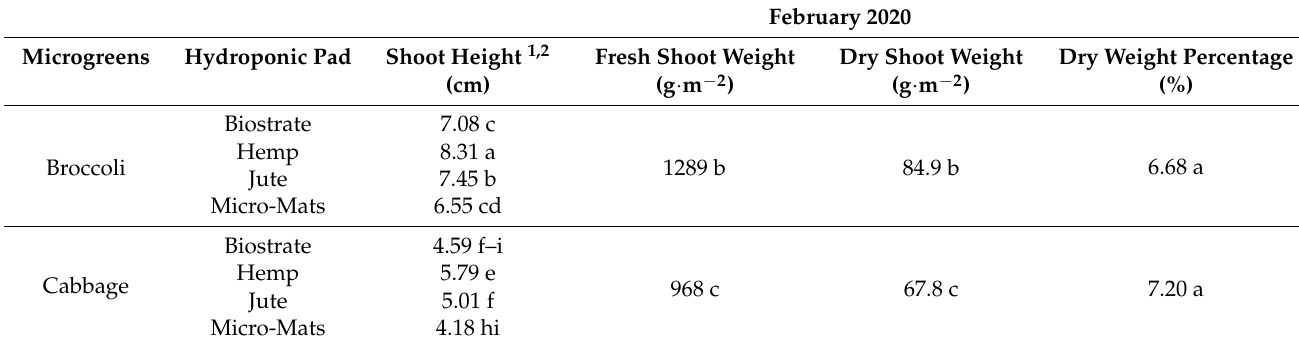
Table 4. Shoot height, fresh shoot weight, dry shoot weight, and dry weight percentage of five microgreens affected by the interaction between species and hydroponic pad type or the main effect of specie in February